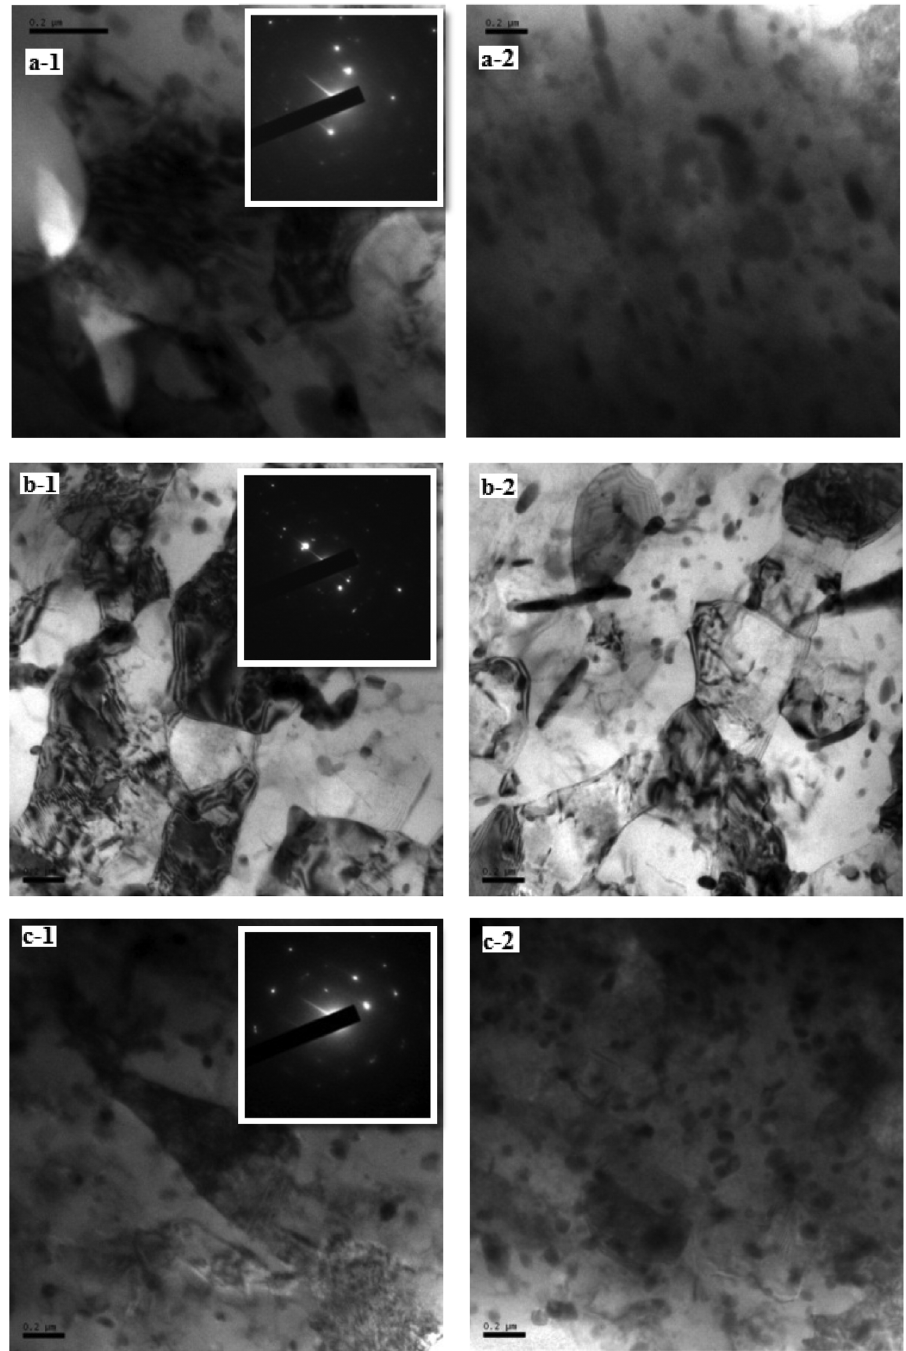
Figure 4: The TEM microstructure of the ECAPed AA7075: one passed (a1 – a2), two passed (b1 – b2), four passed (c1 –